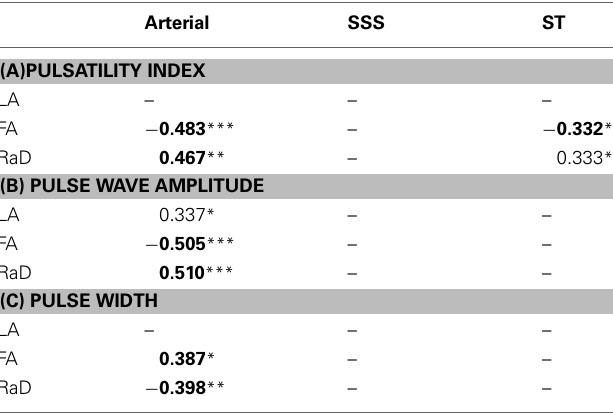
Table 3 | Partial correlations between measures of white matter disruption and measures of pulsatile haemodynamics, correlations in bold were significant after correcting for